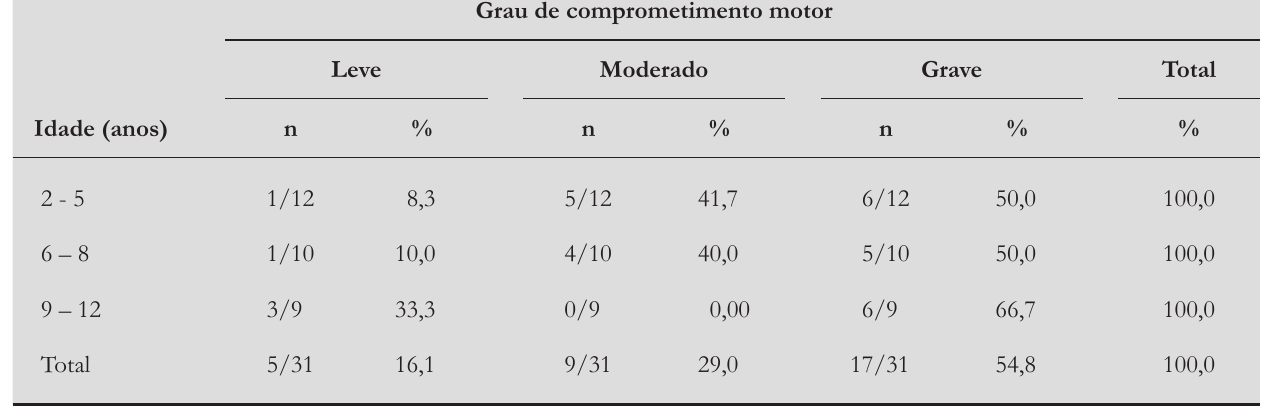
Tabela 1 - Relação entre a idade e o comprometimento motor das crianças e adolescentes com paralisia cerebral (n = 31) Grau de comprometimento motor Leve Moderado Grave